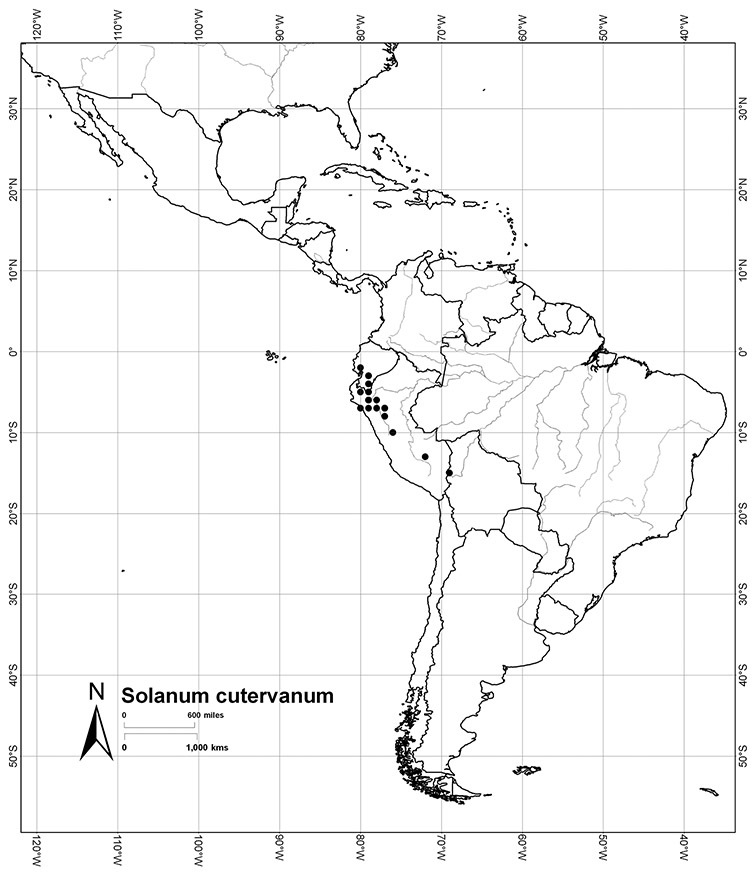
Distribution of Solanum cutervanum Zahlbr.